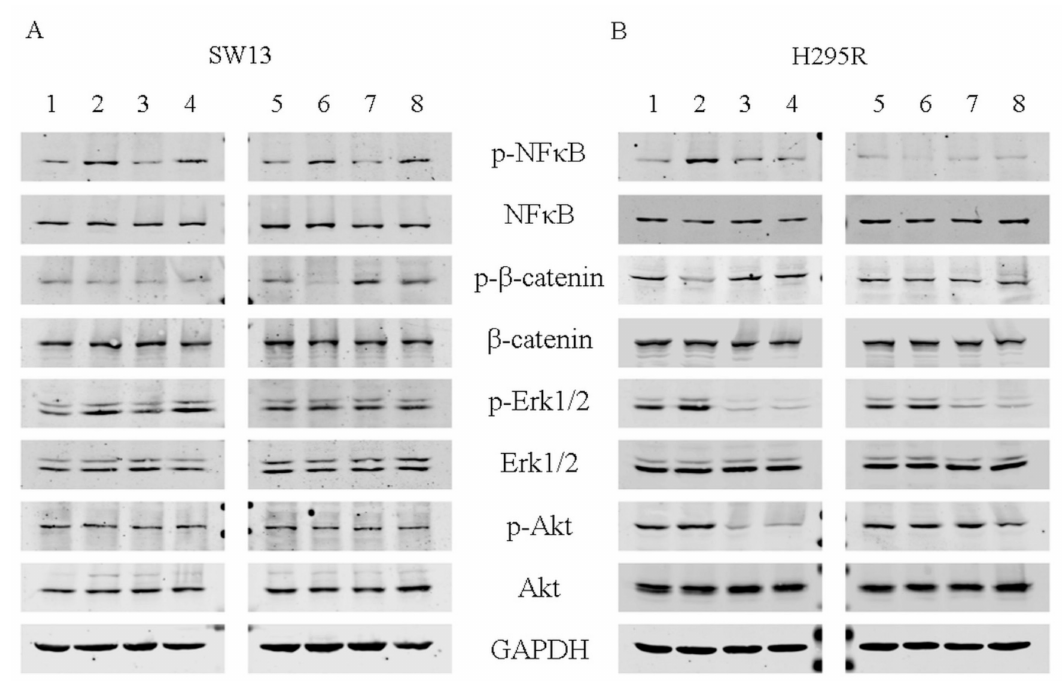
Figure 7. Representative Western blot analyses for adrenocortical tumor cells. ( A ) SW13 cells; ( B ) H295R cells; 1 and 5 = untreated control; 2 and 6 = EF24 at 6.5 µ M for SW13 and 5 µ M for H295R cells; 3 and 7 = mitotane 8 µ M for SW13 cells and 10 µ M for H295R cells; 4 and 8 = EF24 + mitotane. Experiments were performed in triplicate.